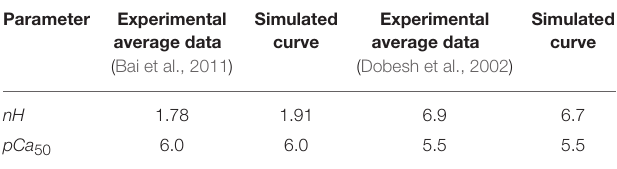
TABLE 2 | Tropomyosin wild-type fit simulation and data properties.